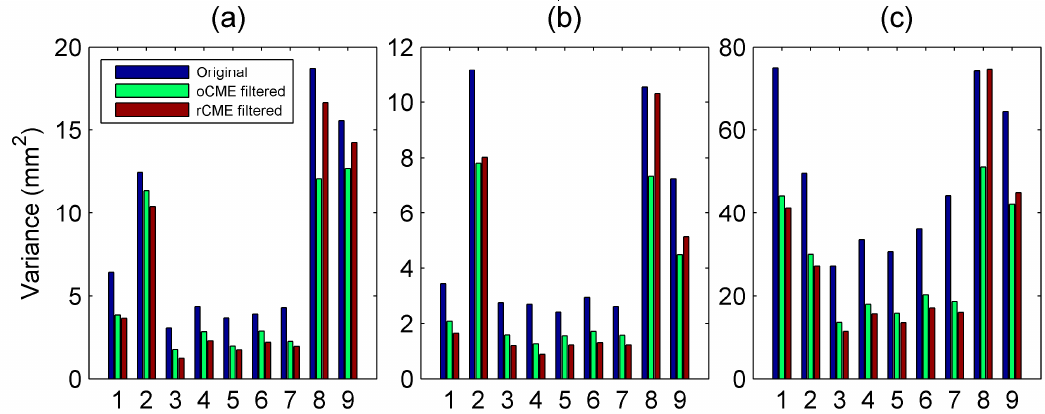
Figure 6. The variances of postfit residuals for ( a ) east, ( b ) north, and ( c ) up components. The bars in blue, green, and red denote variances of the postfit residuals for the original time series and the time series after oCME and rCME filtering, respectively. Except for XIAG and YNYL, most of the variances after rCME correction are less than those corrected with oCME for all three components. The numbers labeling the horizontal axis denote the stations listed in Table 1.